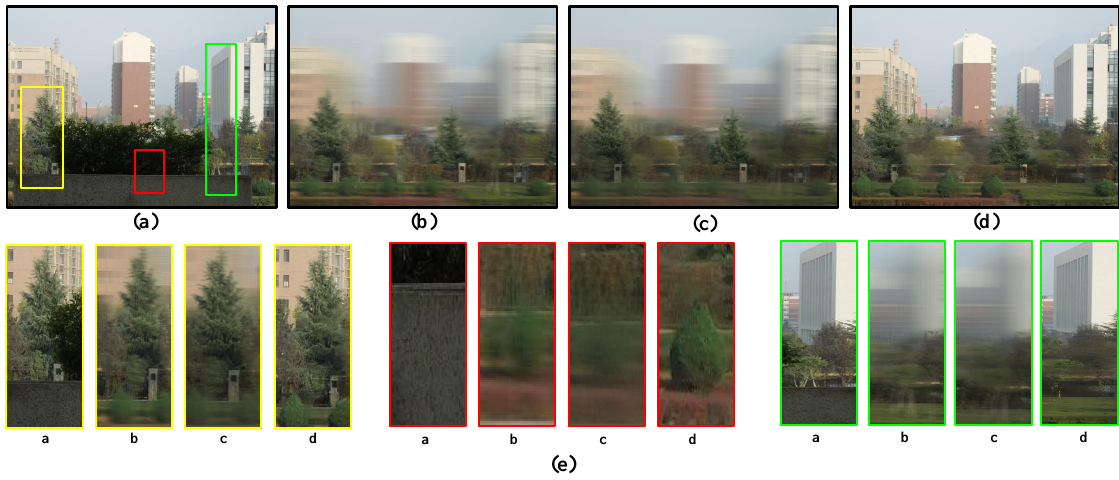
Figure 8. Comparison results of different methods in the challenging outdoor